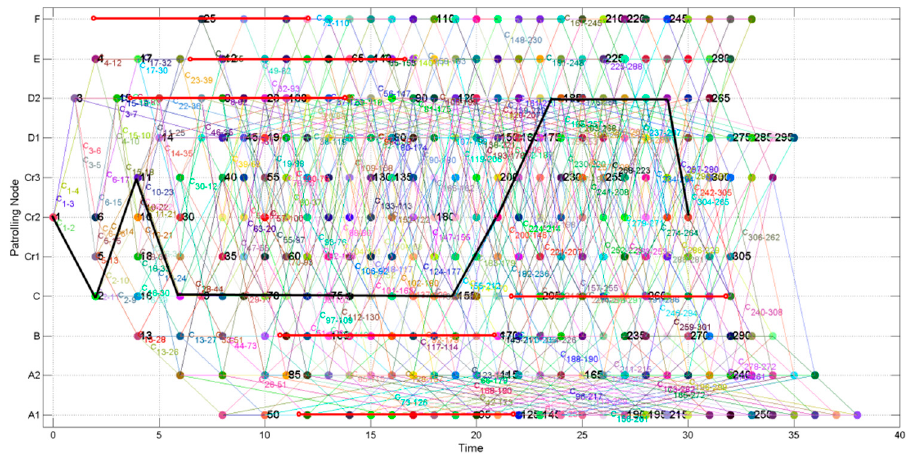
Figure 3. The illustrative example of the transition graph.